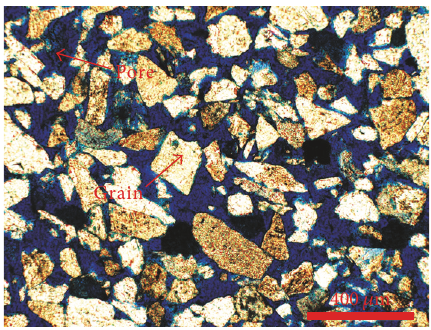
Figure 3: Image of cast Sample